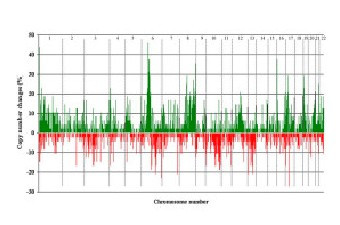
Frequency of DNA copy number changes identified by array CGH in 48 osteosarcomas. The gains and losses are depicted as green and red color bars respectively. Clones are arranged from chromosome 1 to 22 and within each chromosome on the basis of UCSF mapping position.